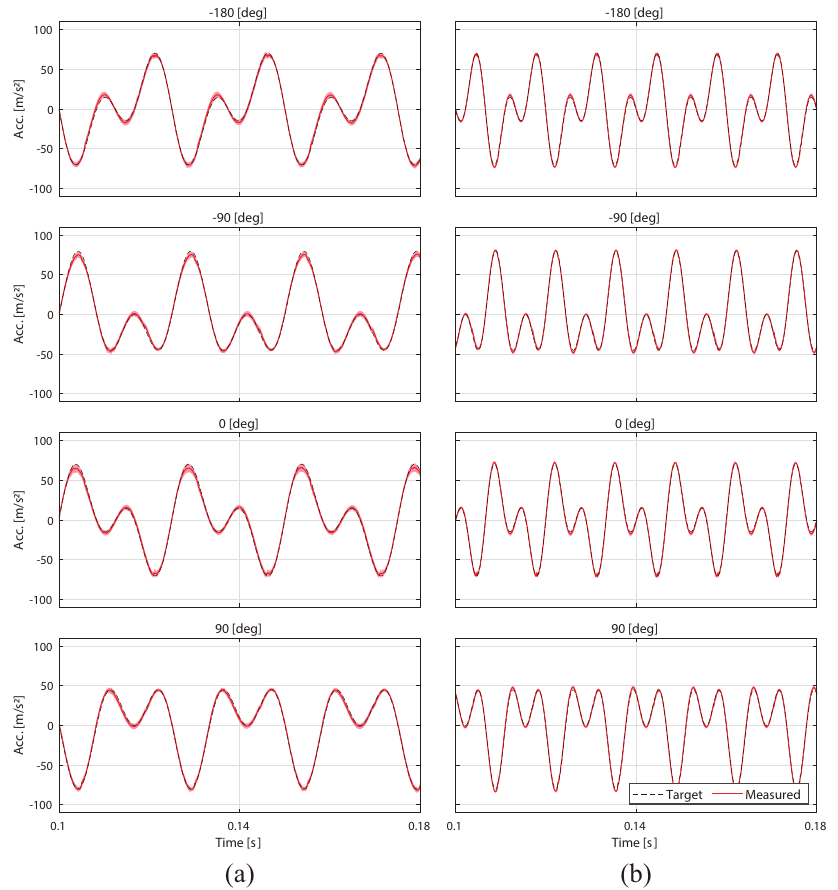
Figure 2. Typical example of an acceleration profile of the fingertips (in Equation (1), φ 0 = − 180, − 90, 0, 90 deg, A 1 = A 2 = 40 m/s 2 , ( a ) f = 40, ( b ) f = 75